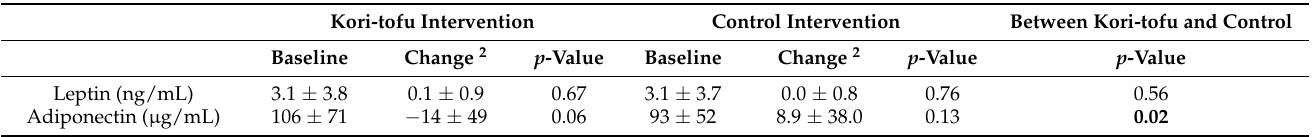
Table 5. Leptin and adiponectin values at baseline and change after 4 weeks intervention with Kori-tofu or control intervention 1